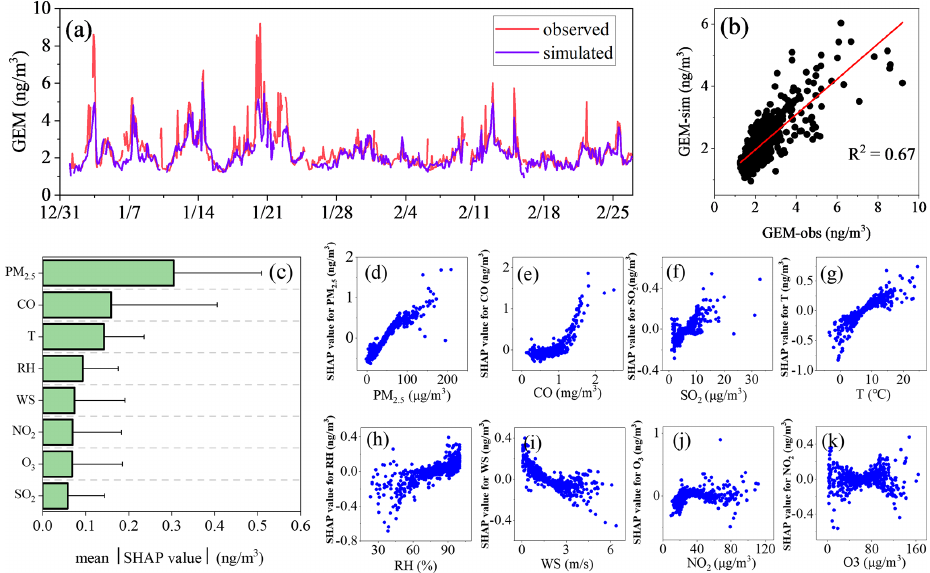
Figure 4. (a) Time series of ANN simulated and observed GEM concentrations during the study period. (b) Linear correlation between observed and ANN simulated GEM concentrations. (c) The ranking of input features calculated via the SHAP algorithm. (d–k) Relationship between the SHAP value and the corresponding concentration of each feature.